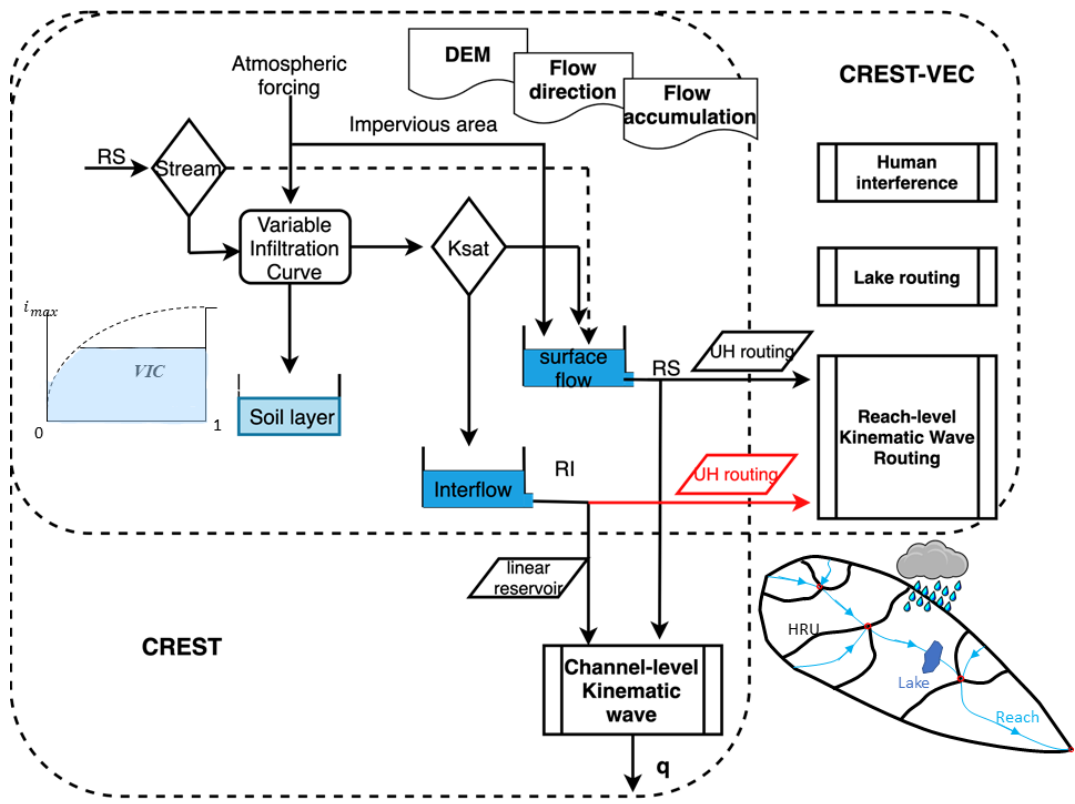
Figure 2. Schematic view of the CREST-VEC framework. The red arrow highlights the newly added subsurface routing option to the original mizuRoute